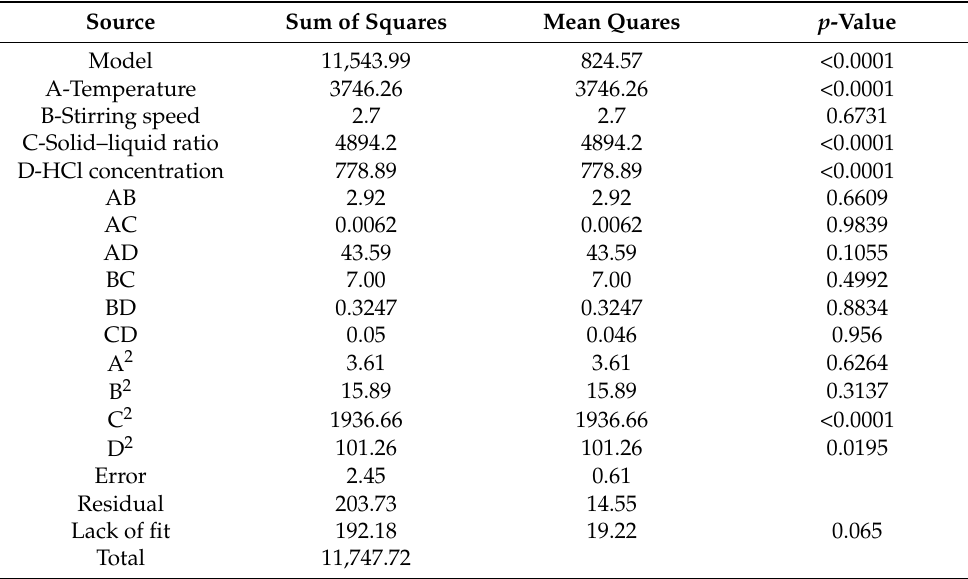
Table 4. ANOVA of the regression model for Sn